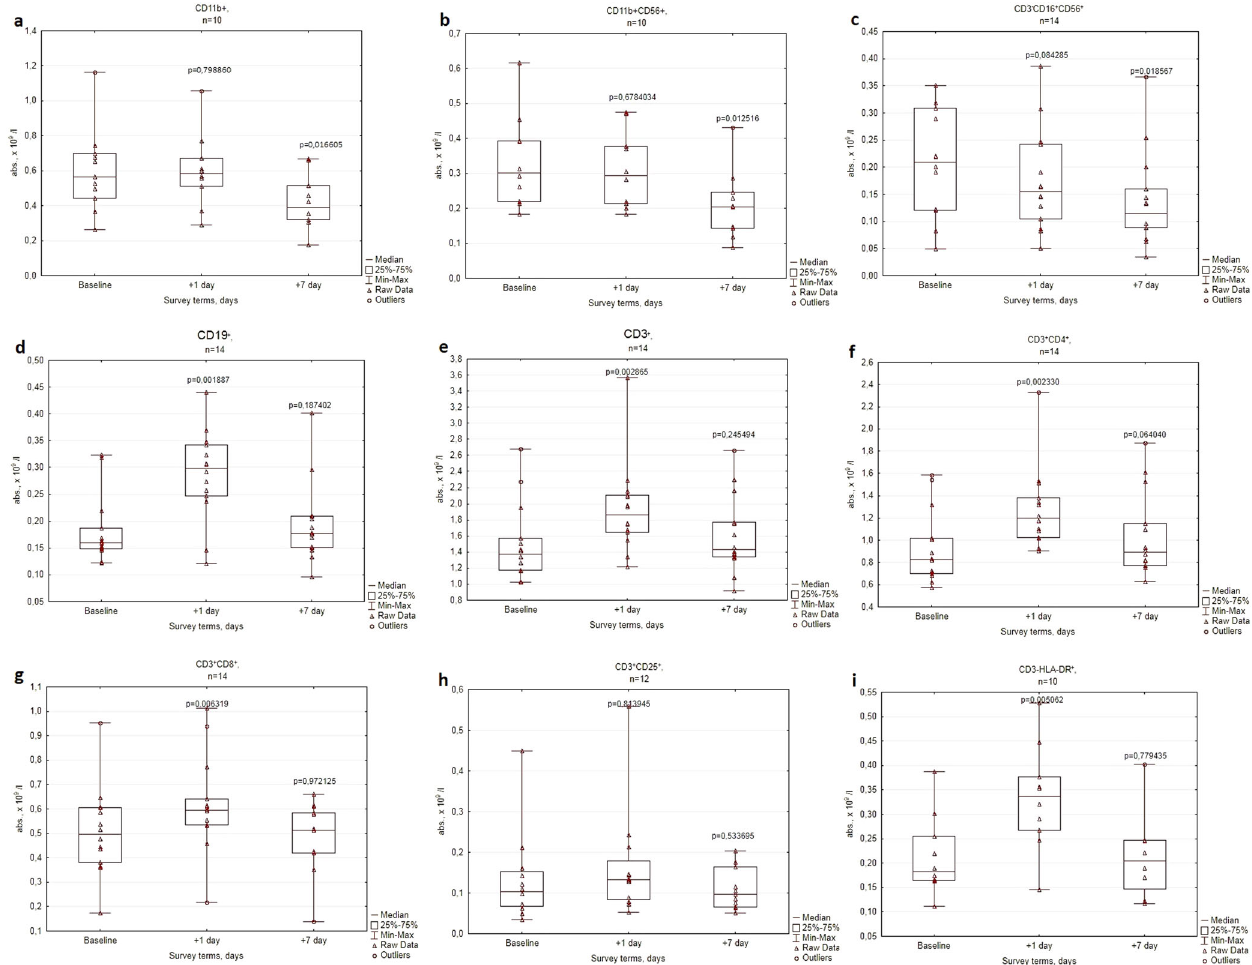
Fig. 3 Lymphocyte subpopulations in peripheral blood of cosmonauts before (Baseline) and after space fl ights (Days + 1 and + 7). a CD11b + , b CD11b + CD56 + , c CD3 - CD16 + CD56 + , d CD19 + , e CD3 + , f CD3 + CD4 + , g CD3 + CD8 + , h CD3 + CD25 + , i CD3 - HLA-DR + . The center lines represent the median, the bounds of boxes represent the 25th percentile and 75th percentile (Q1 and Q2 correspondingly), the bonds of whiskers represent the minimum and the maximum values, the triangles within the diagrams are the raw data for particular volunteers, p values were obtained using the Wilcoxon ’ s